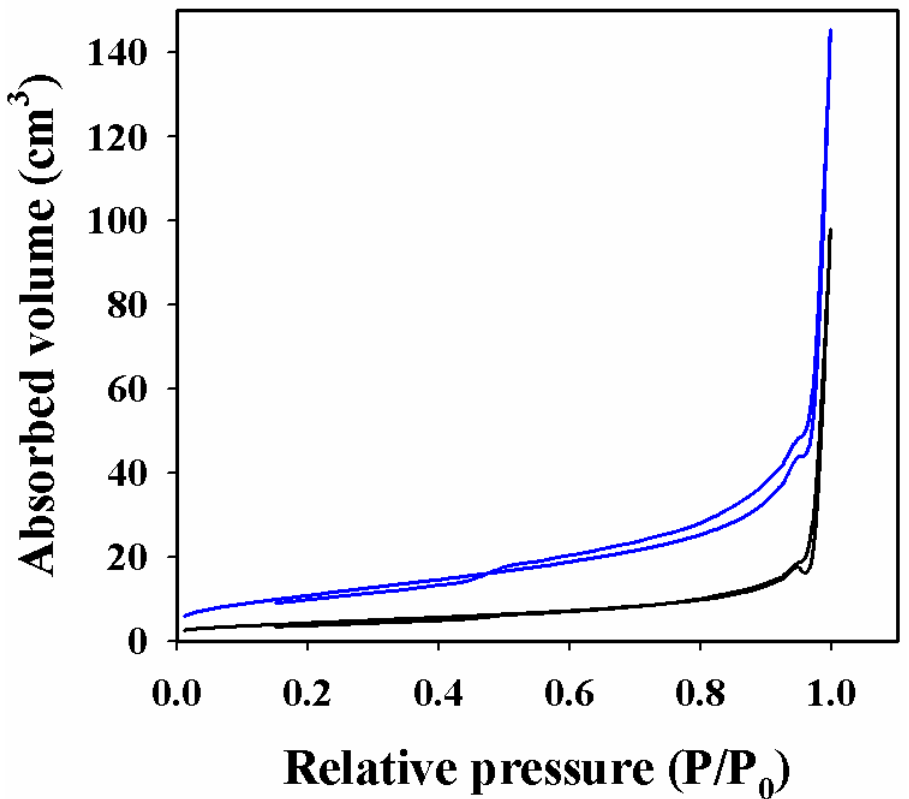
Figure 4. BET analysis of (black line) SrSnO 3 and (blue line) Ag–Chitosan/SrSnO 3 NCs. Black line refers to the BET results of SrSnO 3 . Blue line refers to the BET results of Ag-Chitosan/SrSnO 3 NCs